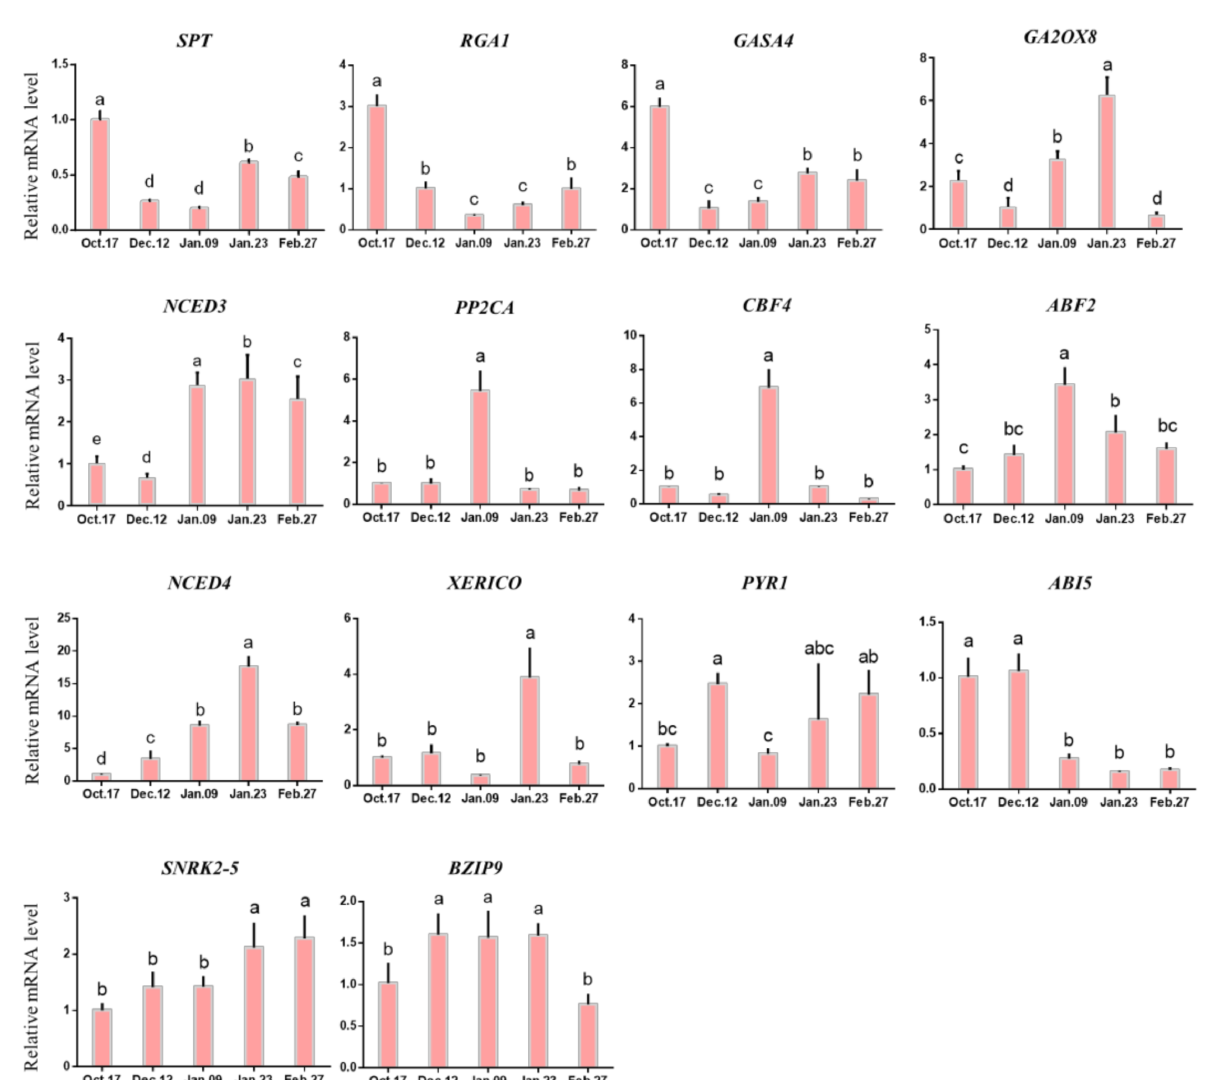
Figure 10. Expression of hormone metabolism-related genes in different dormancy stages. Each bar represents the mean ± SEM ( n = 3). Different letters indicate a significant difference among different dates ( p < 0.05). The picture was drawn by GraphPad Prism 8.0 and the data were processed by IBM SPSS Statistics